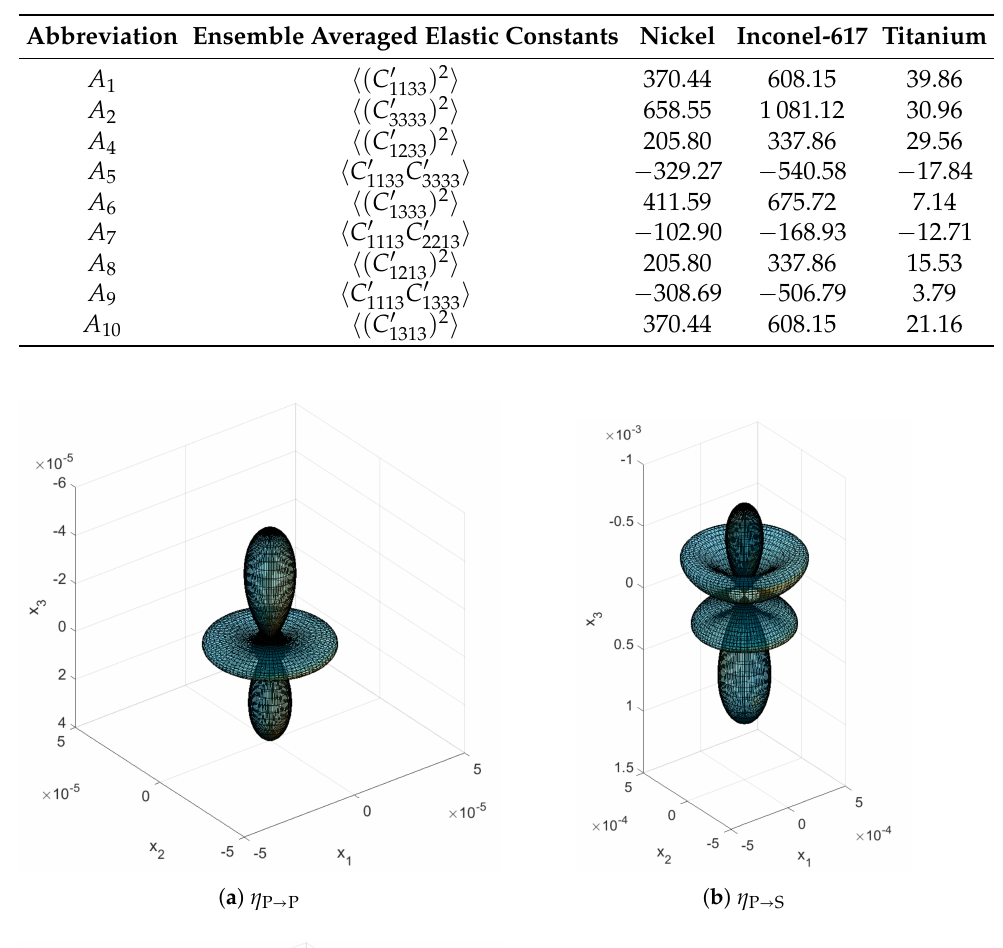
Table 2. Ensemble averaged elastic constants (in GPa 2 ) as used for the calculation of backscattering coefficients [40].